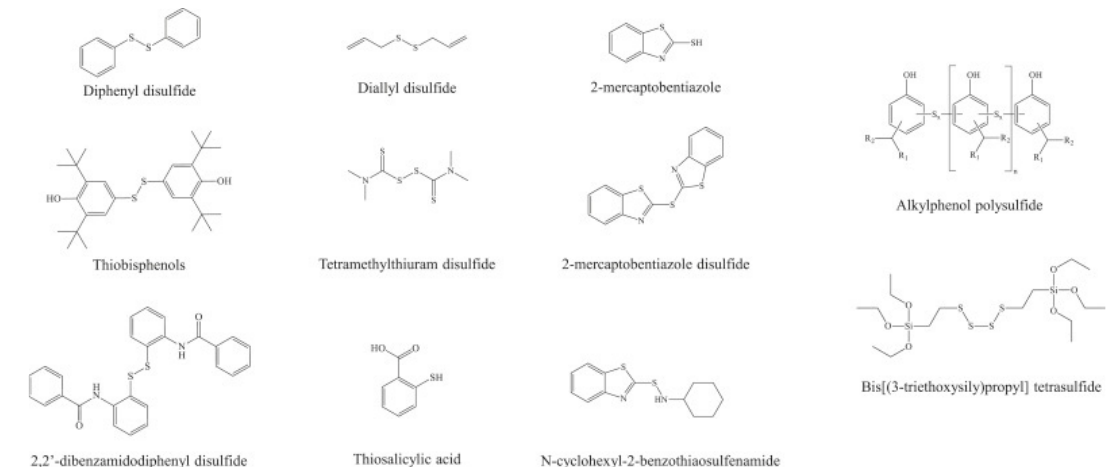
Figure 15. Typical sulfides and mercaptans used in tire regeneration (reproduced with permission from [28]).